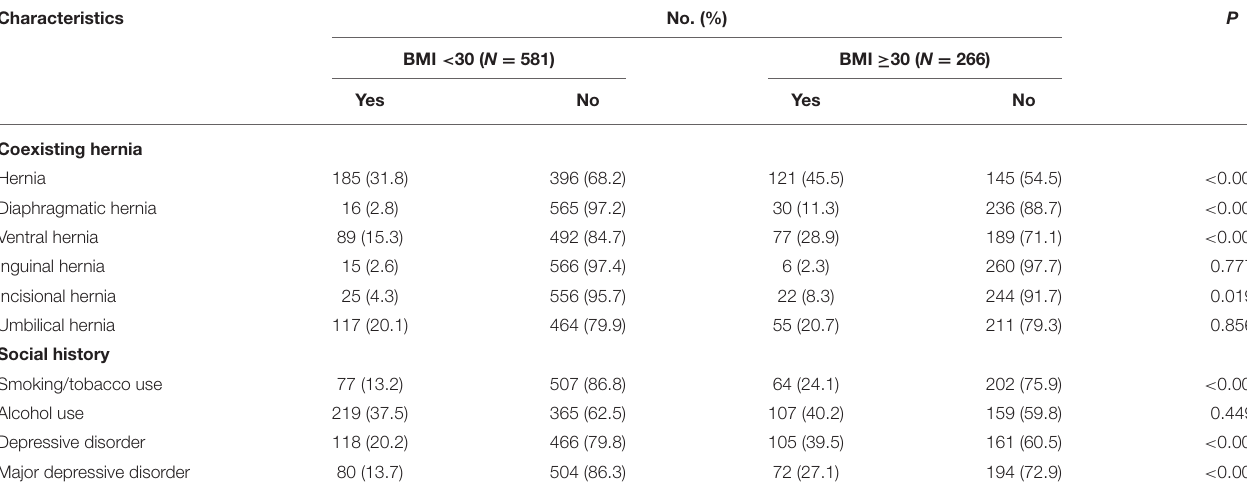
TABLE 3 | Characteristics of RAD women depending on BMI category. Characteristics